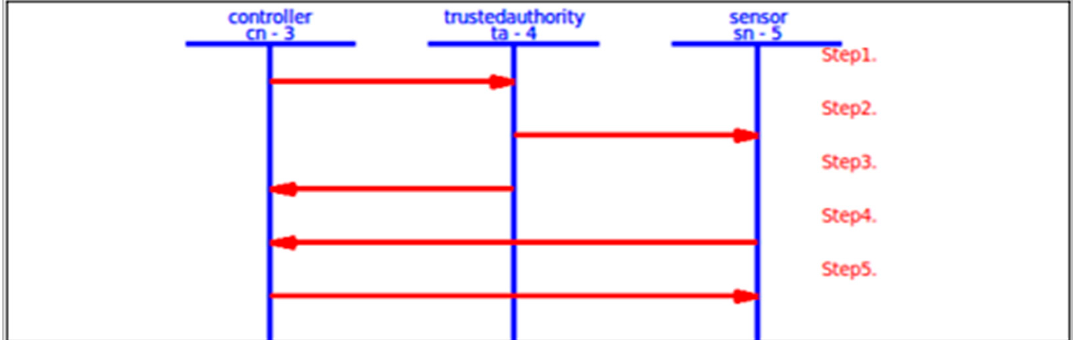
Figure 10. SPAN animator of protocol-I.